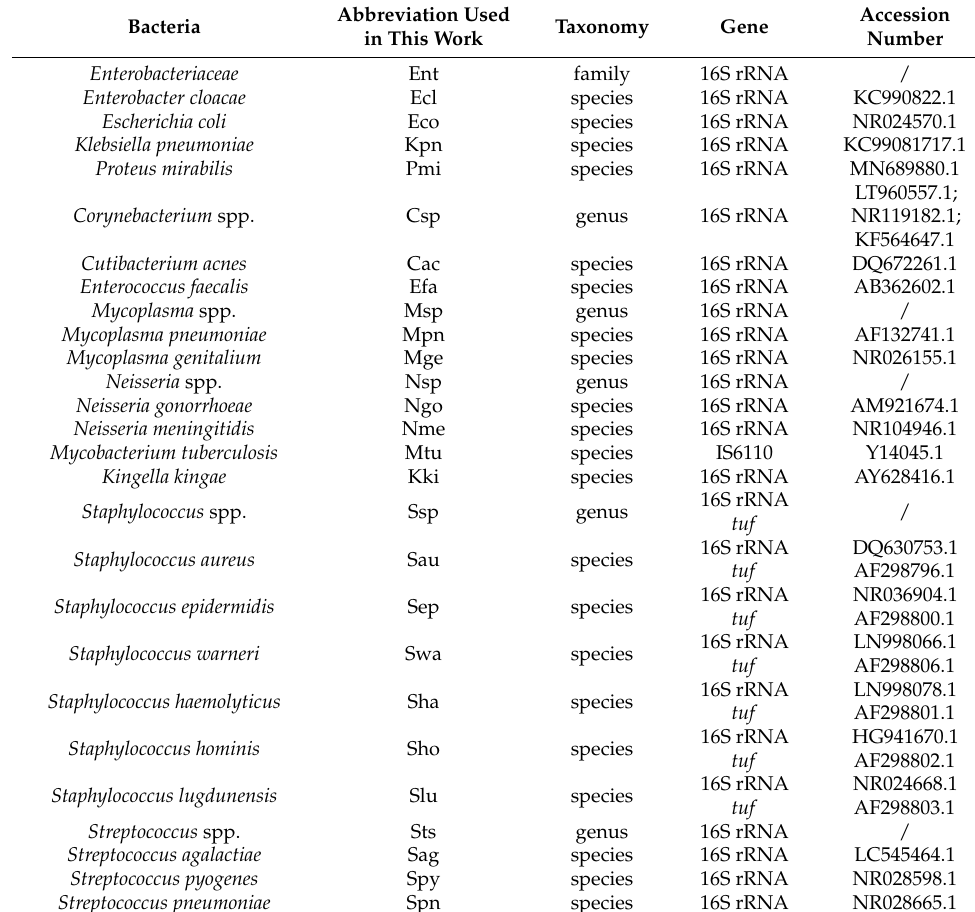
Table 1. List of bacteria usually implicated in PJI and targeted by the DendrisCHIP ® OA.